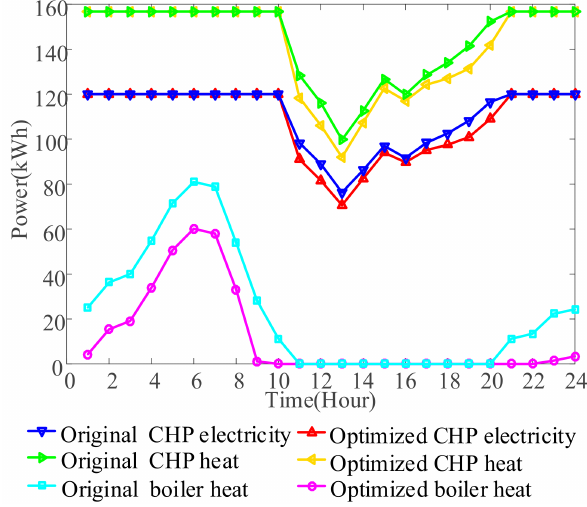
Figure 7. Energy Supply of MT and Boiler.